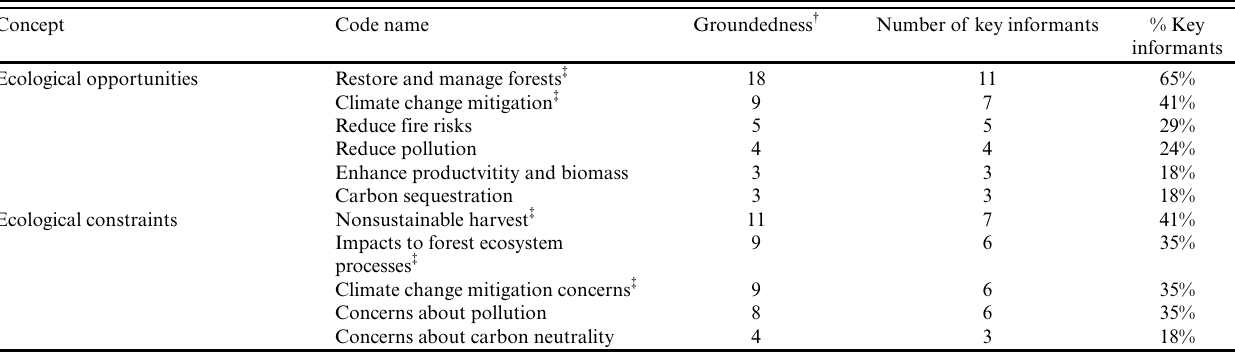
Table 4 . Ecological opportunities and constraints of wood-based bioenergy (WBB) in western Montana. For each root code and subcode, we include the number of times the code was referred to in the interviews (groundedness), the number of key informants that discussed the code, and the percentage of key informants that described the